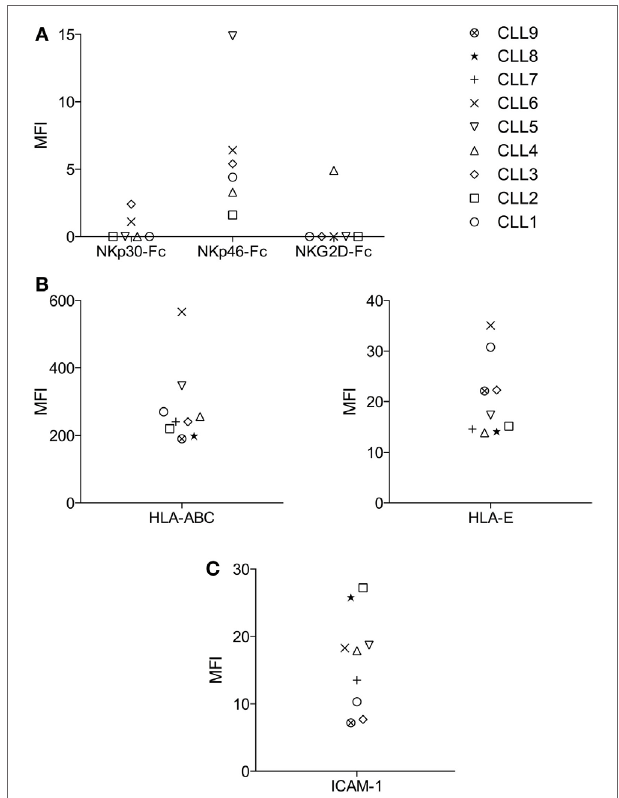
FigUre 3 | analyses of the expression of activating and inhibitory ligands of nK cell receptors in B-cll cells . Expression of NKp30, NKp46, and NKG2D activating ligands using Fc quimeras (a) , HLA-ABC and HLA-E inhibitory ligands (B) , and the adhesion molecule ICAM-1 (c) using specific antibodies were analyzed in B-CLL cells by flow cytometry as described in Section “Materials and Methods.” The Mean fluorescence intensity (MFI) of every B-CLL sample is represented in the graphs. MFI = (MFI specific Ab) − (MFI isotype control).